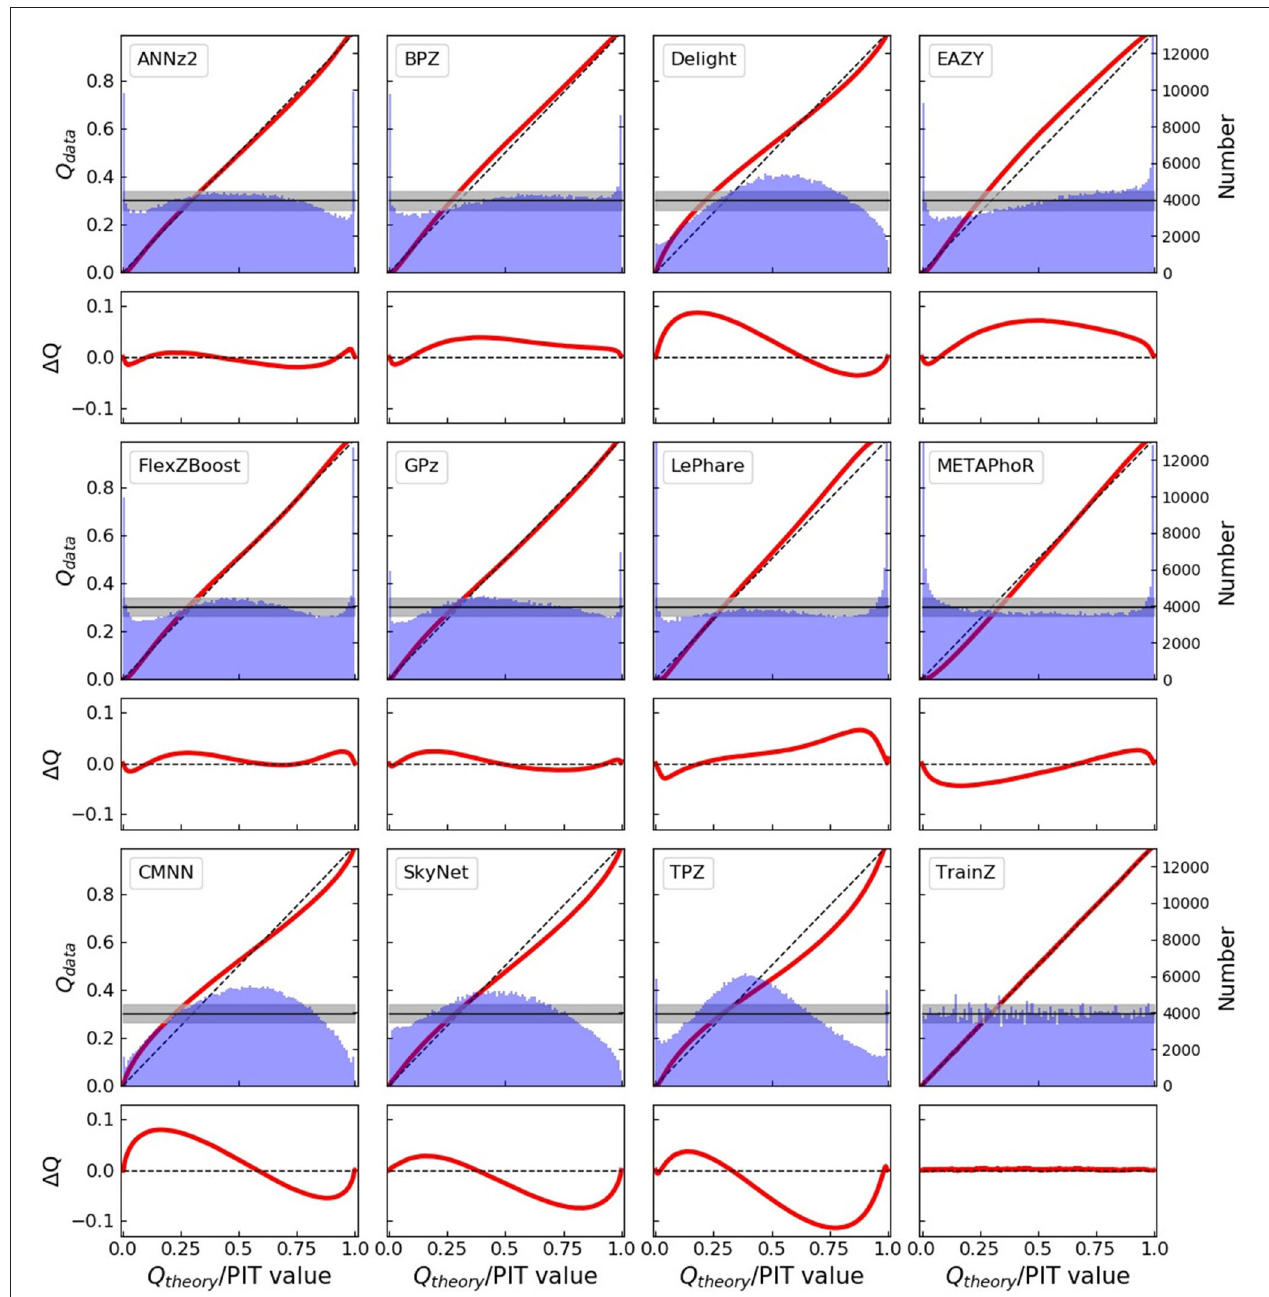
FIGURE 1 | Figure from Schmidt et al. (2020). Statistical comparison among different methods for photo-z PDFs within the LSST Challenge (see Schmidt et al., 2020 for further details). The panels show the QQ plots (red) and PIT histograms (blue) with the superimposed ideal QQ (black dashed diagonal) and ideal PIT (gray horizontal) curves, including a residual plot for the QQ estimation with respect to the ideal diagonal (lower inset). In the last bottom right panel, TrainZ is the fake PDF described in section 2.4.